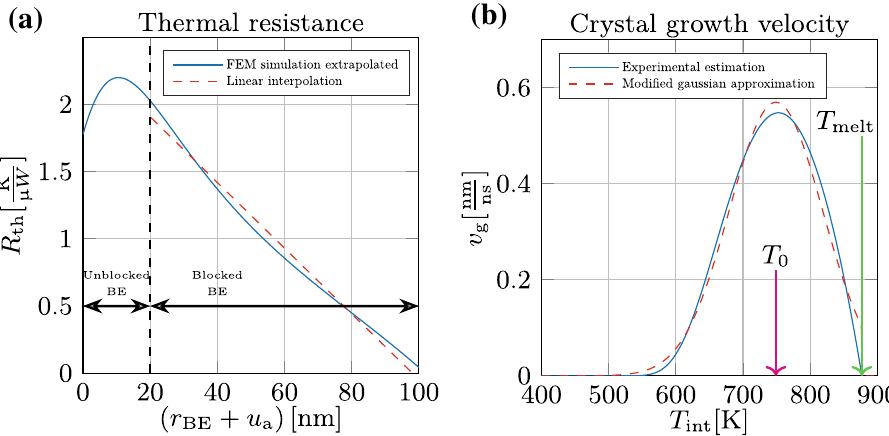
Figure 4. Effective thermal resistance and crystal growth velocity. ( a ) The effective thermal resistance of a mushroom-type PCM device as a function of the amorphous thickness u a . This is obtained from Finite-element modeling that was also experimentally corroborated by Sebastian et al. 19 . Also shown is a linear approximation of the effective thermal resistance in the scenario where the bottom-electrode is fully blocked by the amorphous region (dashed-red line). ( b ) The experimentally measured crystal growth velocity v g ( T int ) as a function of the interface temperature T int based on Sebastian et al. 19 . Also shown is a Gaussian approximation (dashed-red